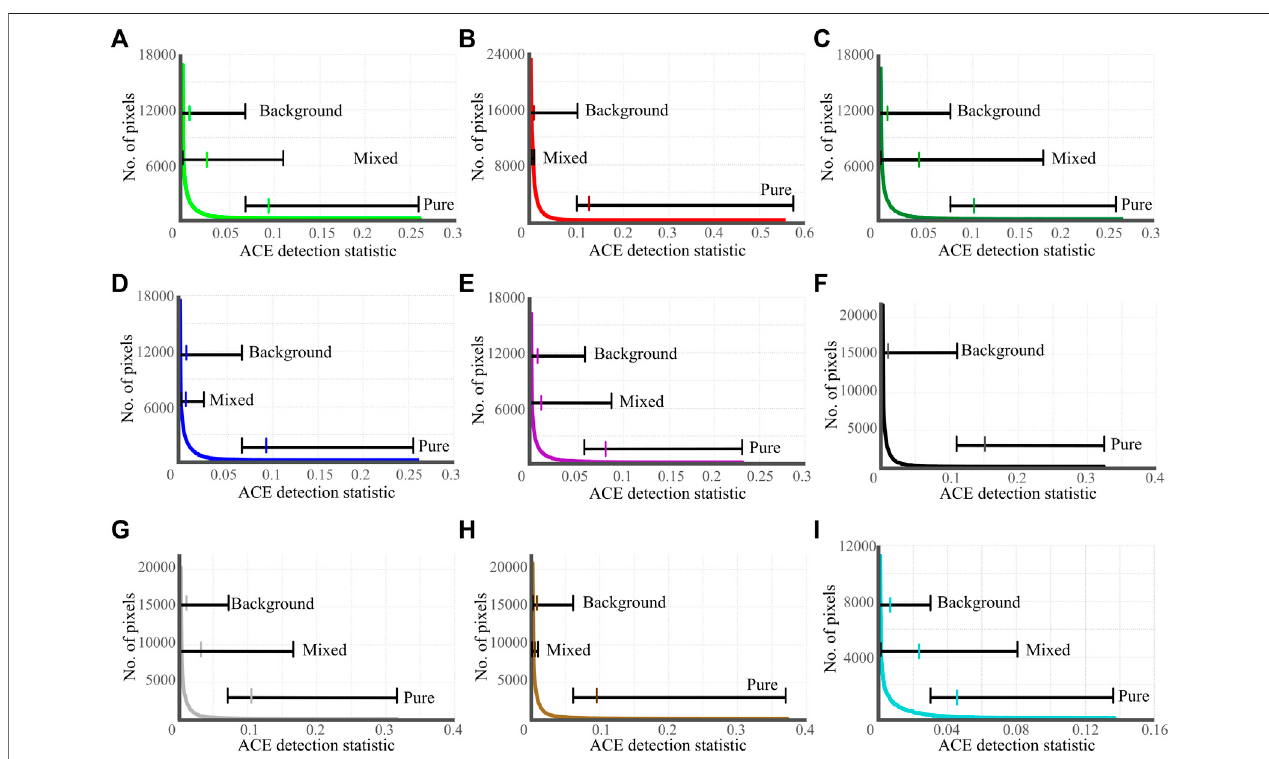
FIGURE9| Results ofthe ACEtargetdetection. Curvesdepict thenumber ofpixels accordingtothe ACE detection statistic assigned.Horizontalbars indicate the range of ACE detection statistic values attributable to each type of pixel (pure target, mixed target, background) with the mean value indicated by a coloured tick mark. Pure and background pixels are separated at the threshold values presented in Table SM3.6; mixed pixel ranges were determined according to ACE detection statistic values of mixed transect points. (A) Chara sp. (B) Metaphyton. (C) P. richardsonii . (D) Potamogeton sp. (E) Ribbon. (F) Road, no mixed pixels identi fi ed. (G) Silt/ Rock. (H) Non-vegetation. (I)